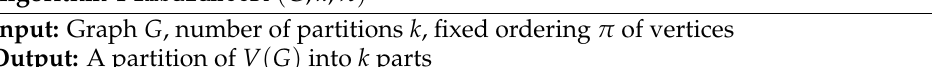
Algorithm 4 ImbalanceDP ( G , k , π